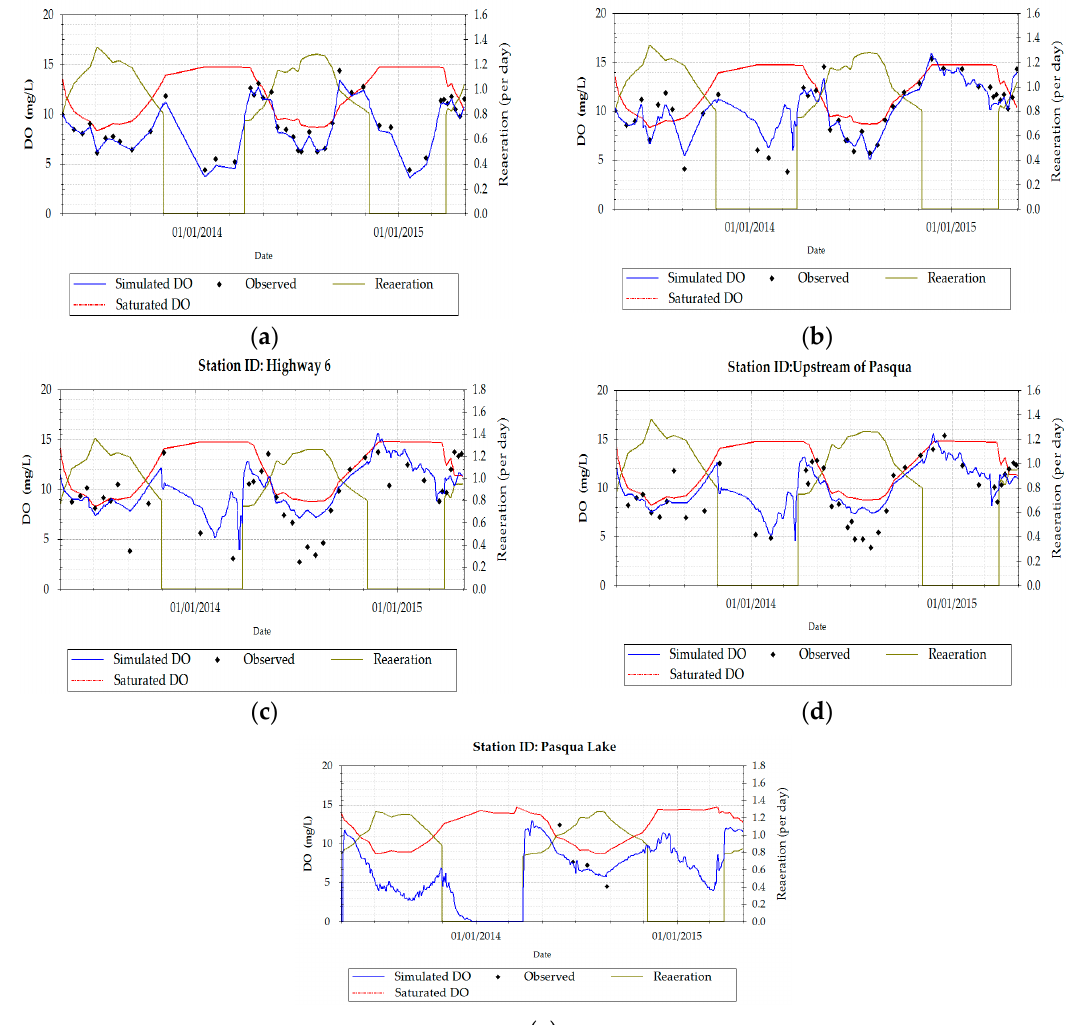
Figure 5. Simulated and sampled dissolved oxygen for the calibration and validation periods: the left and right vertical axes represent dissolved oxygen and reaeration coefficient, respectively; from the upstream of the study area, ( a ) Lumsden; ( b ) Craven; ( c ) Highway 6; ( d ) upstream of Pasqua Lake; and ( e ) Pasqua lake.